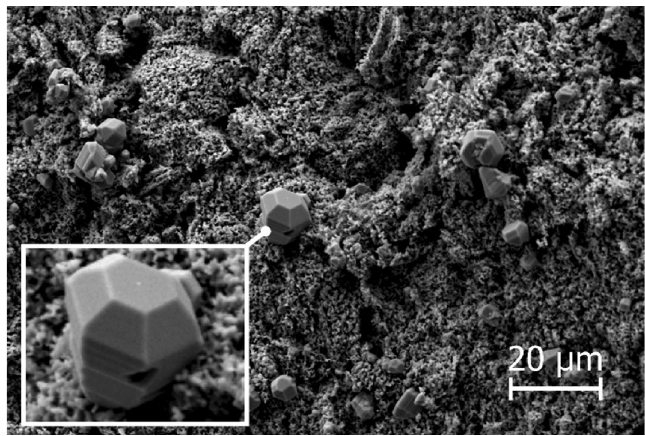
Figure 8. The SiC structure formed at 1750 °C using pure Ar as the process gas.